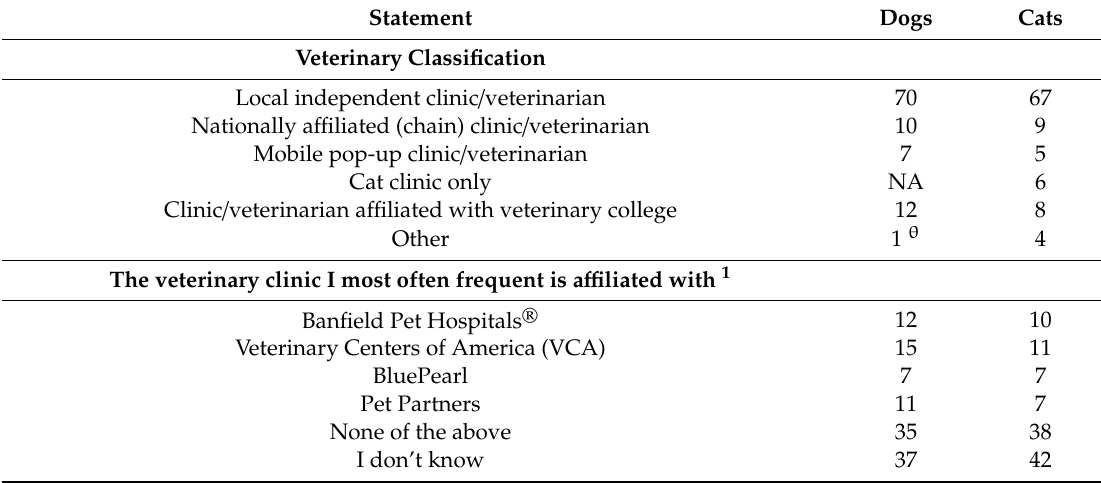
Table 4. Pet owner-reported veterinarian classification and vet clinic a ffi liation, percent (%) of dog (n = 477) and cat (n = 352)